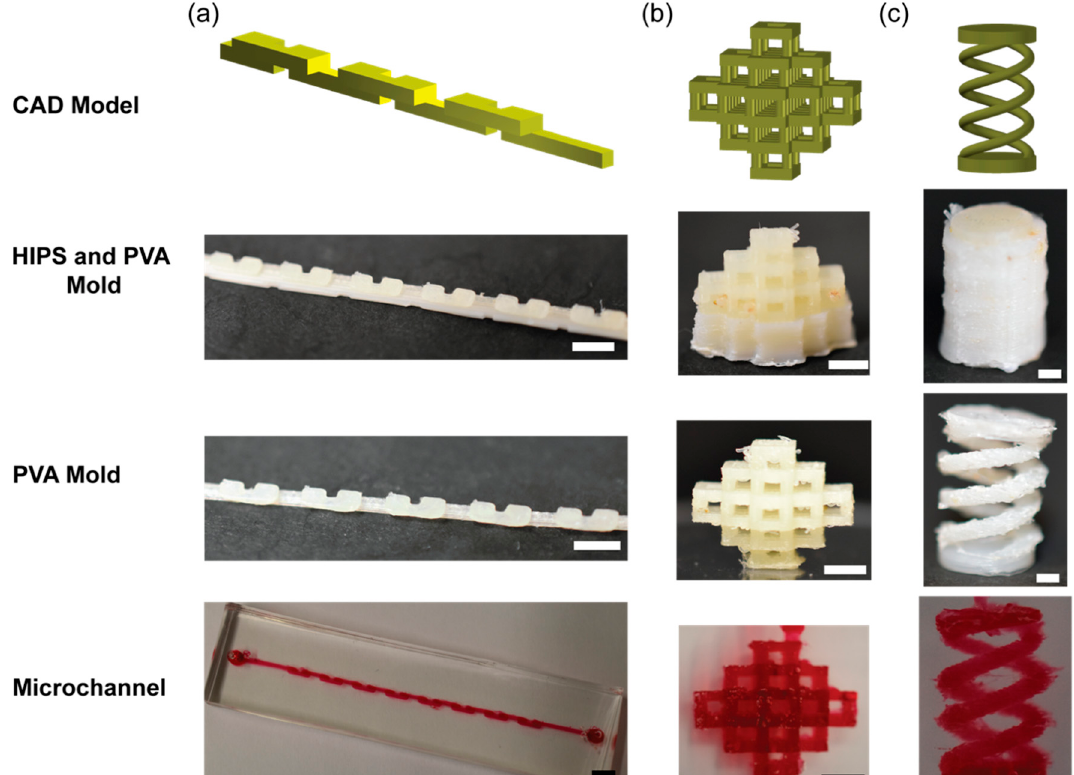
Figure 5. The CAD model of the three representative designs of the 3D microchannels, and optical images of the three major stages of dual sacrificial molding: after dual extrusion of HIPS (SM1) and PVA (SM2), after the removal of HIPS to obtain the PVA mold, and after the removal of PVA mold embedded in PDMS to obtain microchannels. ( a ) Serpentine mixer microchannel; ( b ) Multilayer pyramid network of microchannels; ( c ) Dual helix microchannel. The width and height of the channels with rectangular cross sections, denoted as ( w , h ), were ( a ) (600 µ m, 800 µ m) and ( b ) (800 µ m, 800 µ m). For ( c ), The diameter of the microchannel with circular cross sections was 800 µ m. The dual helix mold was designed with 2.5 turns, a base radius of 5 mm and height of 20 mm. Scale bars = 3.0 mm for ( a ), 2.5 mm for ( b ), and 2.0 mm for ( c